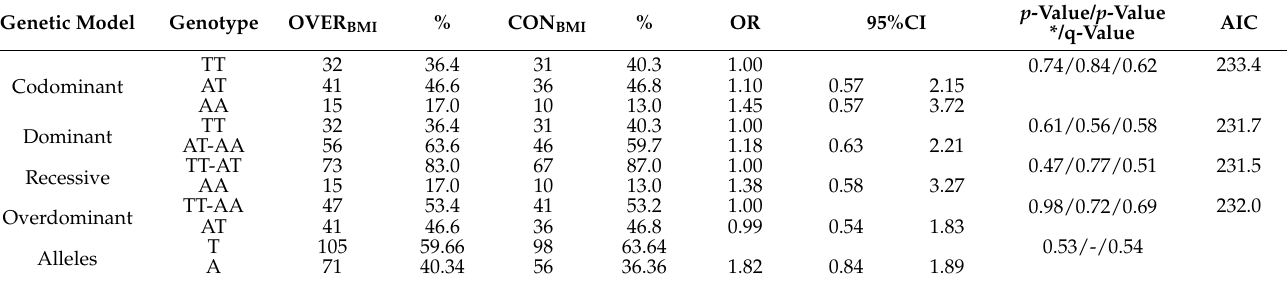
Table 5. Association analysis of the FTO (rs9939609) polymorphism with BMI.